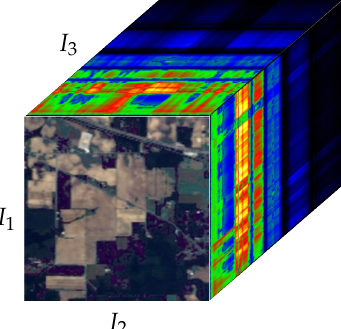
Figure 1. AVIRIS HSI of Indian Pines, NW Indiana. NASA/JPL